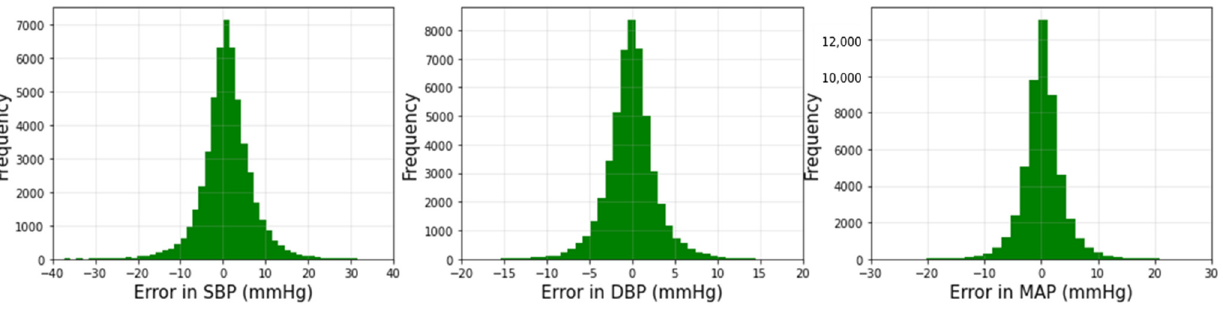
Figure 5. Histograms of error for estimated real-time SBP, DBP, and MAP values.